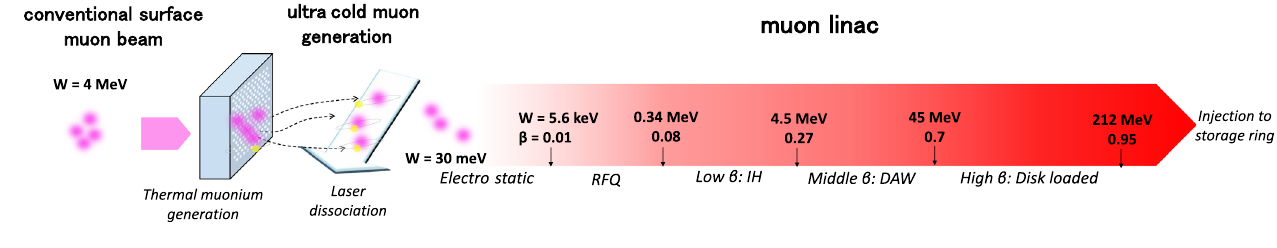
FIG. 1. Configuration of low-emittance muon